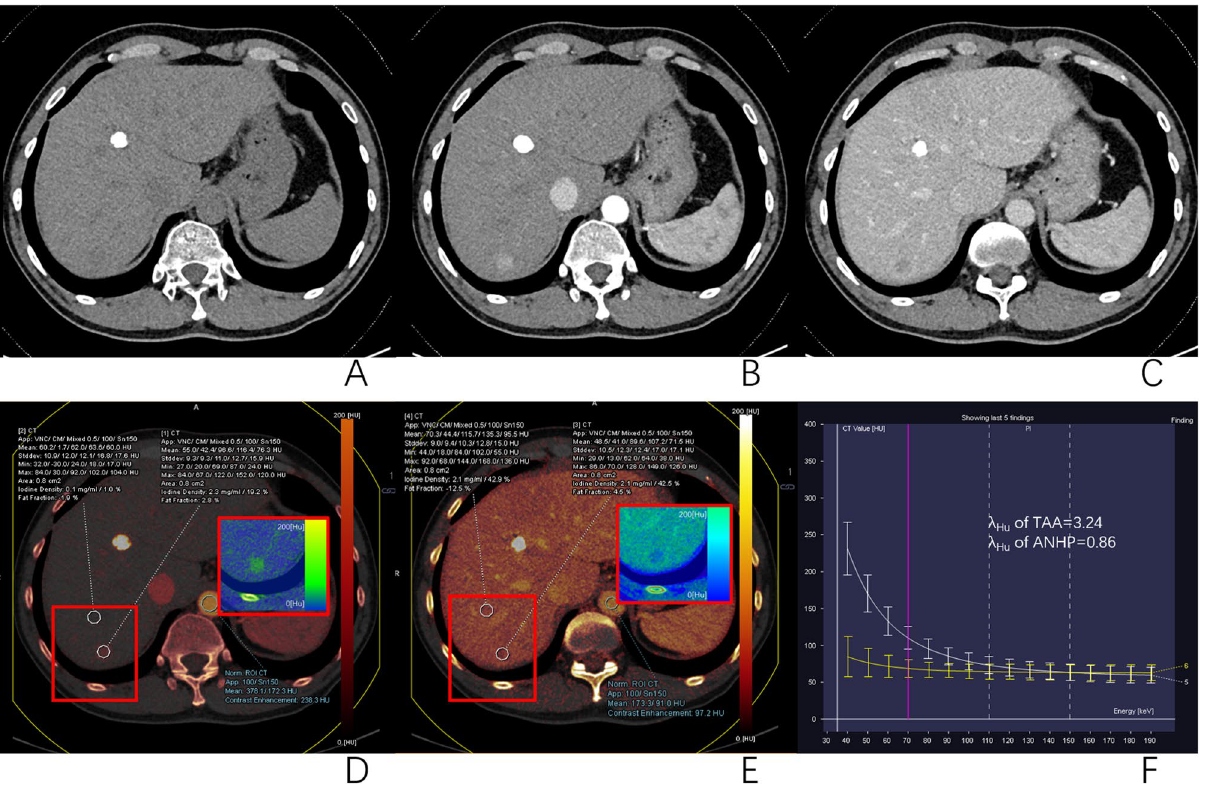
Figure 4. DECT images of a 52-year-old man with HCC undergoing lipiodol TACE. The right hepatic lobe showed the original lesions were completely deposited with lipiodol, and the new lesions appeared, a low- attenuation nodule on axial unenhanced CT image ( A ), significant enhancement at the arterial phase ( B ), and wash-out at the portal venous phase( C ). ROIs of TAA and ANHP ( D and E ) placed on arterial and portal iodine map showed IC and NIC of TAA to be 2.3 mg/ml and 19.2% at arterial phase, and 2.1 mg/ml and 42.5% at portal venous phase. IC and NIC of ANHP was 0.1 mg/ml and 1.0% at arterial phase, and 2.1 mg/ml and 42.9% at portal venous phase. The λ Hu of TAA and ANHP was 3.24 and 0.86, respectively ( F ).